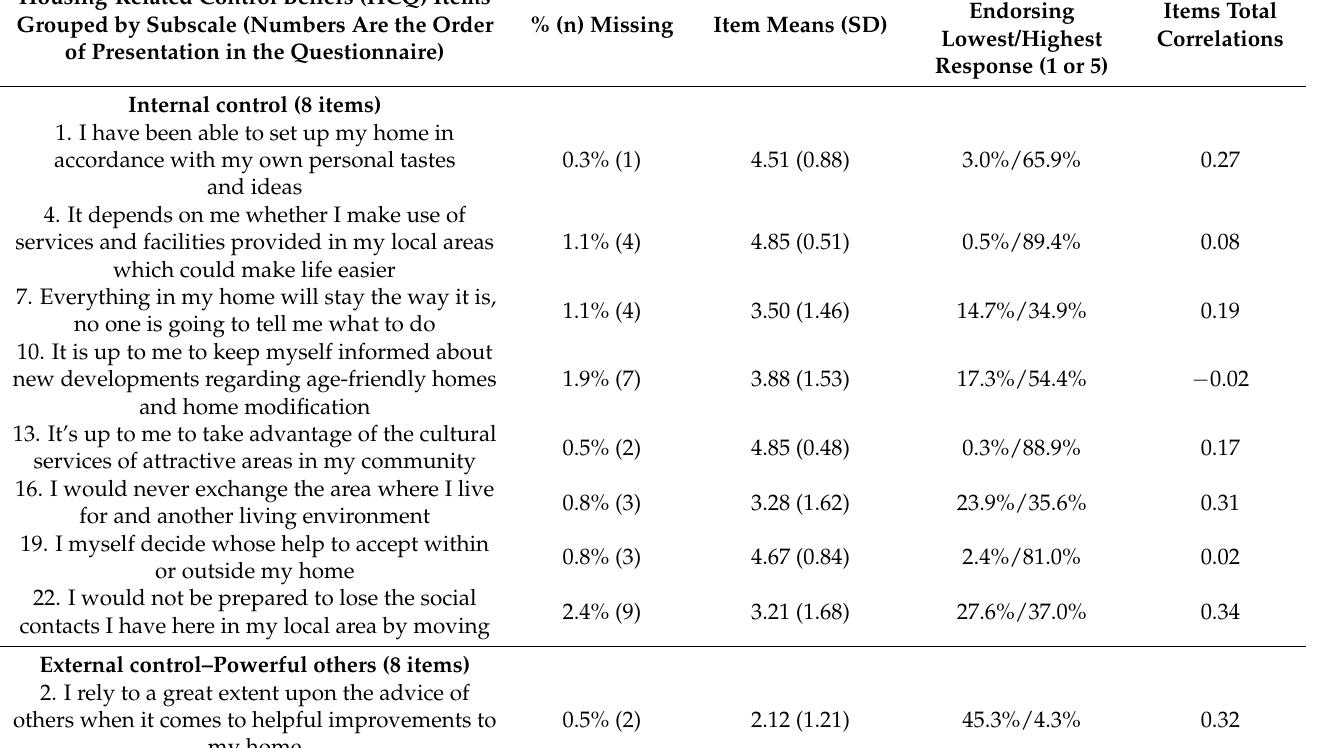
% of Participants Items Total Endorsing Correlations Lowest/Highest Response (1 or 5)